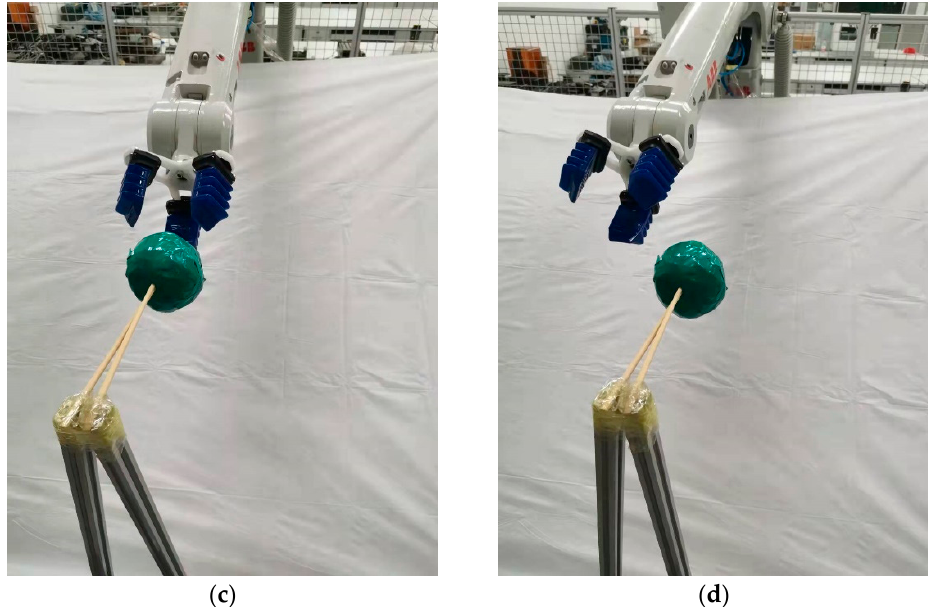
Figure 6. Path sequence with the PPRO-RRT algorithm in obstacle avoidance. ( a – d ) represent different states of the manipulator and obstacle at each moment.